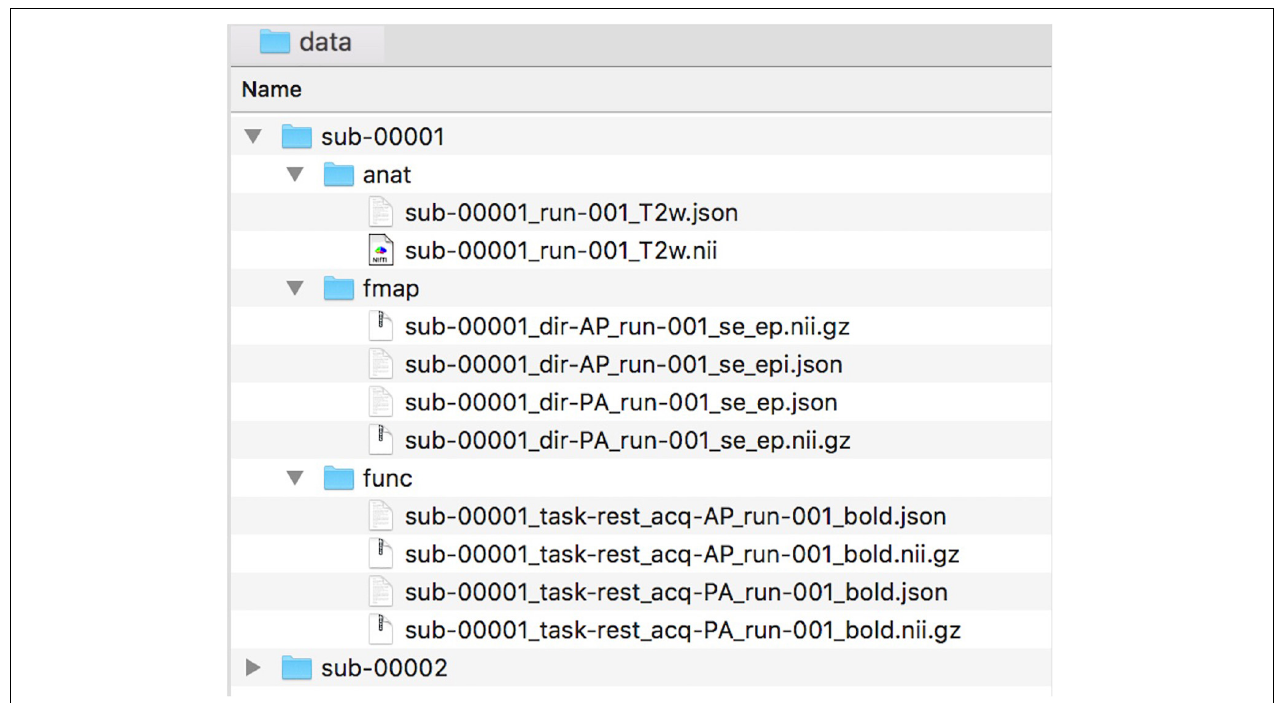
FIGURE 1 | Example of data naming and organization for NeoRS.